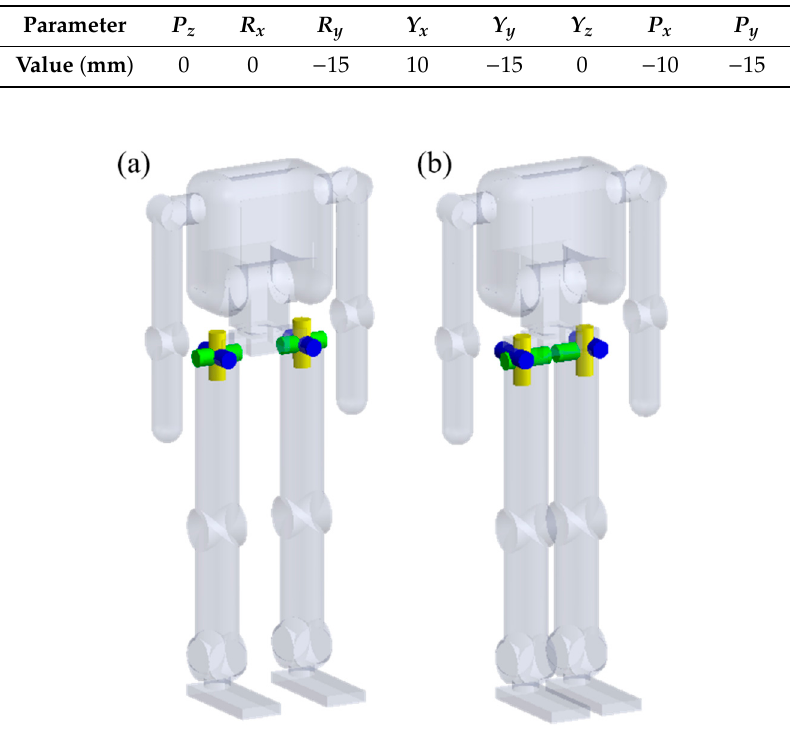
Table 5. Parameter values of the model after the second optimization.